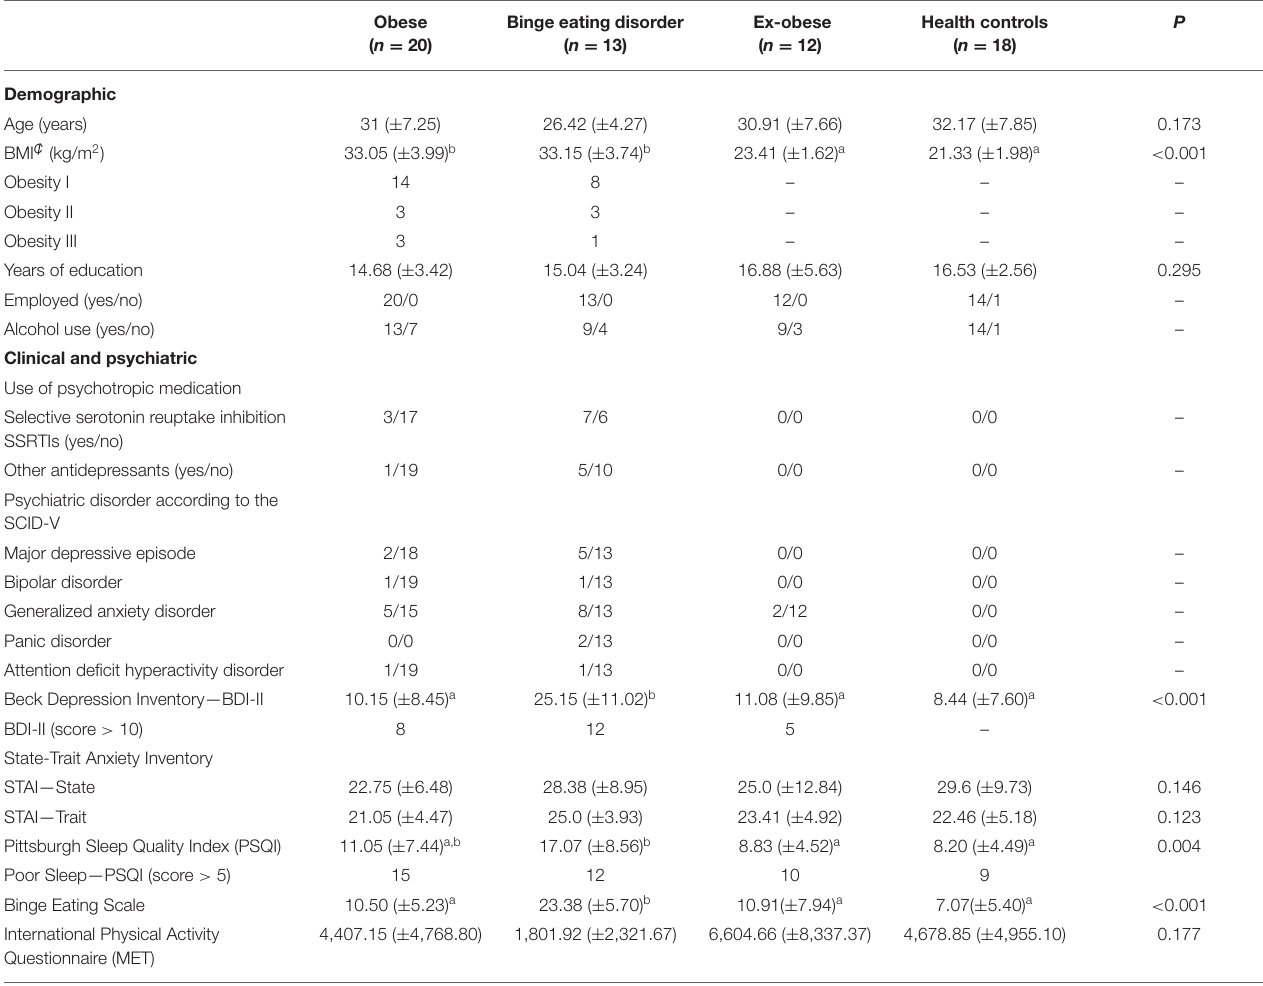
TABLE 1 | Demographic and clinical